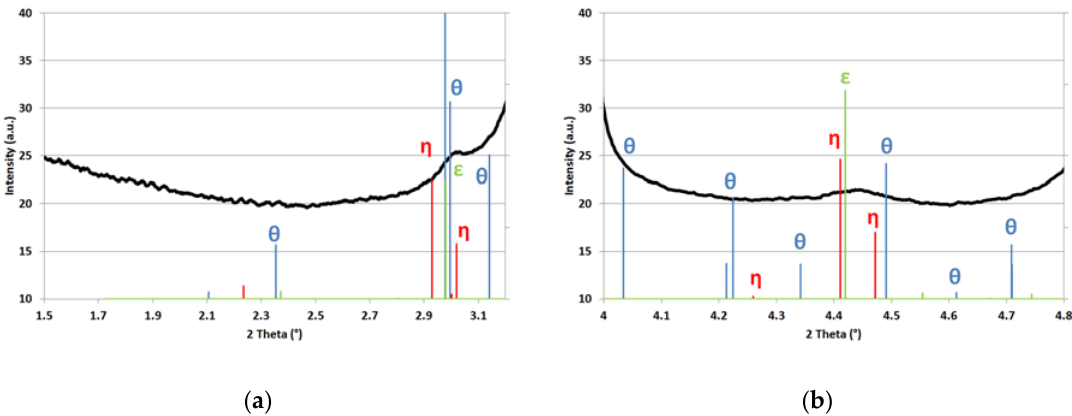
Figure 5. 1D experimental diffractogram (black continuous curve) and position of simulated diffraction peaks of possible carbides (cementite in blue, eta carbide in red, and epsilon carbide in green); ( a , b ) diffraction angle windows corresponding to the first and second minor diffraction peaks in Figure 4b respectively.